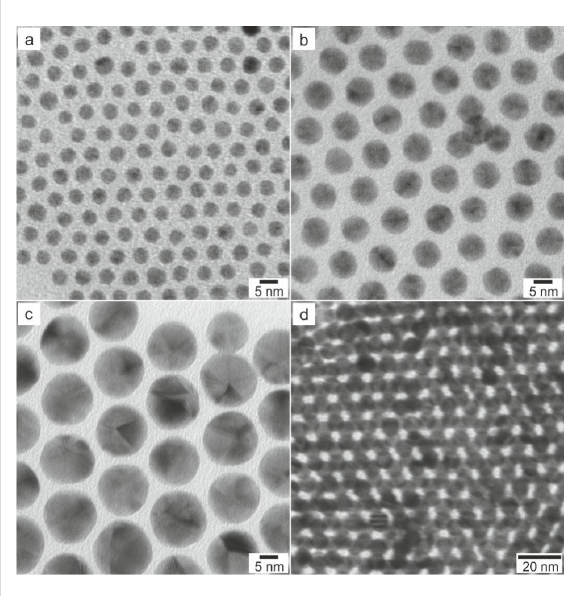
Figure 9: TEM bright field images of Au@MnO and Au@Fe 3 O 4 heterodimer-nanoparticles: (a) 9@18 nm Au@MnO, (b) 4@22 nm